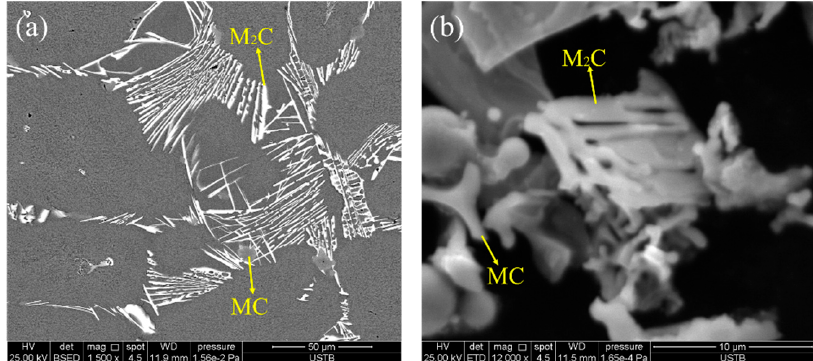
Figure 4. Two-dimensional morphology ( a ) and three-dimensional morphology ( b ) of carbides.